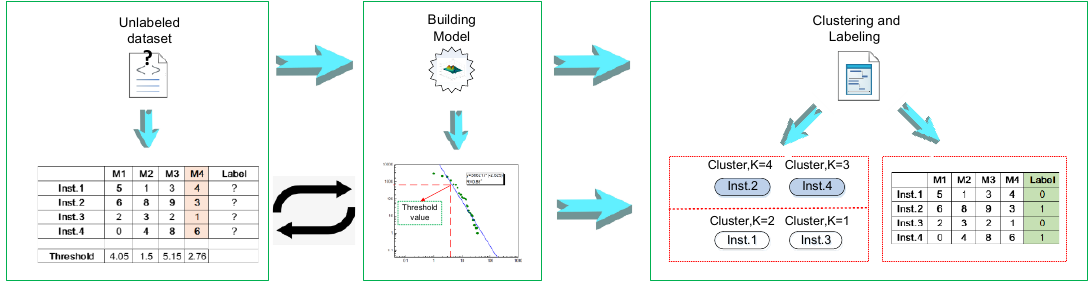
Figure 4. The overall process of the proposed unsupervised approach in software defect prediction. 192 The process is stated in detail as follows. 193